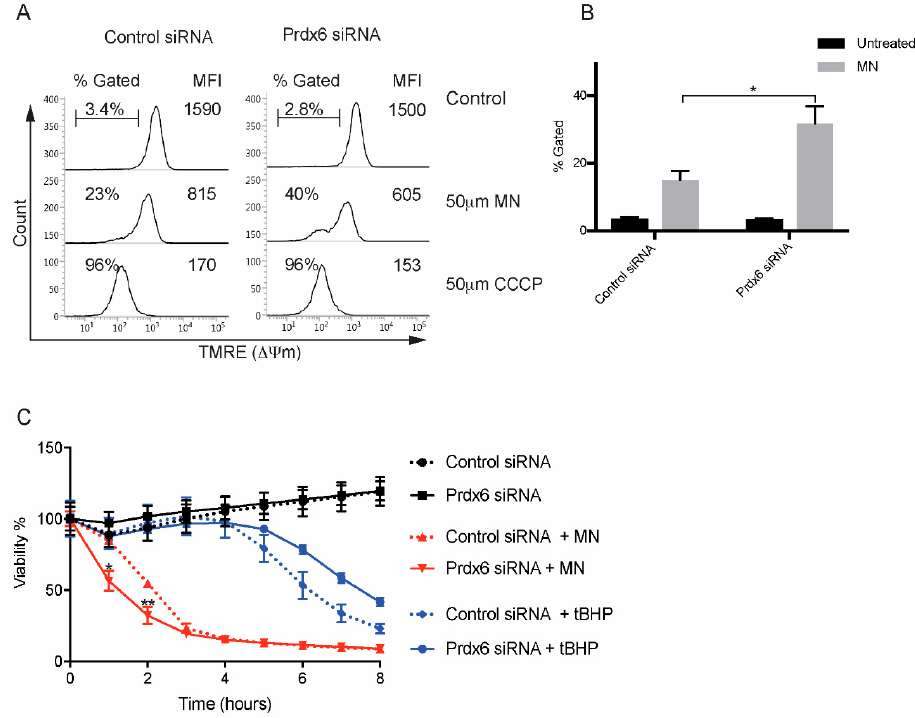
Figure 5. Prdx6-deficient cells are susceptible to cell death induced by menadione MN. ( A ) Representative FACS plots of TMRE mitochondrial membrane potential ( ΔΨ m) in siRNA-transfected B4G12 cells following treatment with 50 m MN (90 min) or 50 μ m CCCP (15